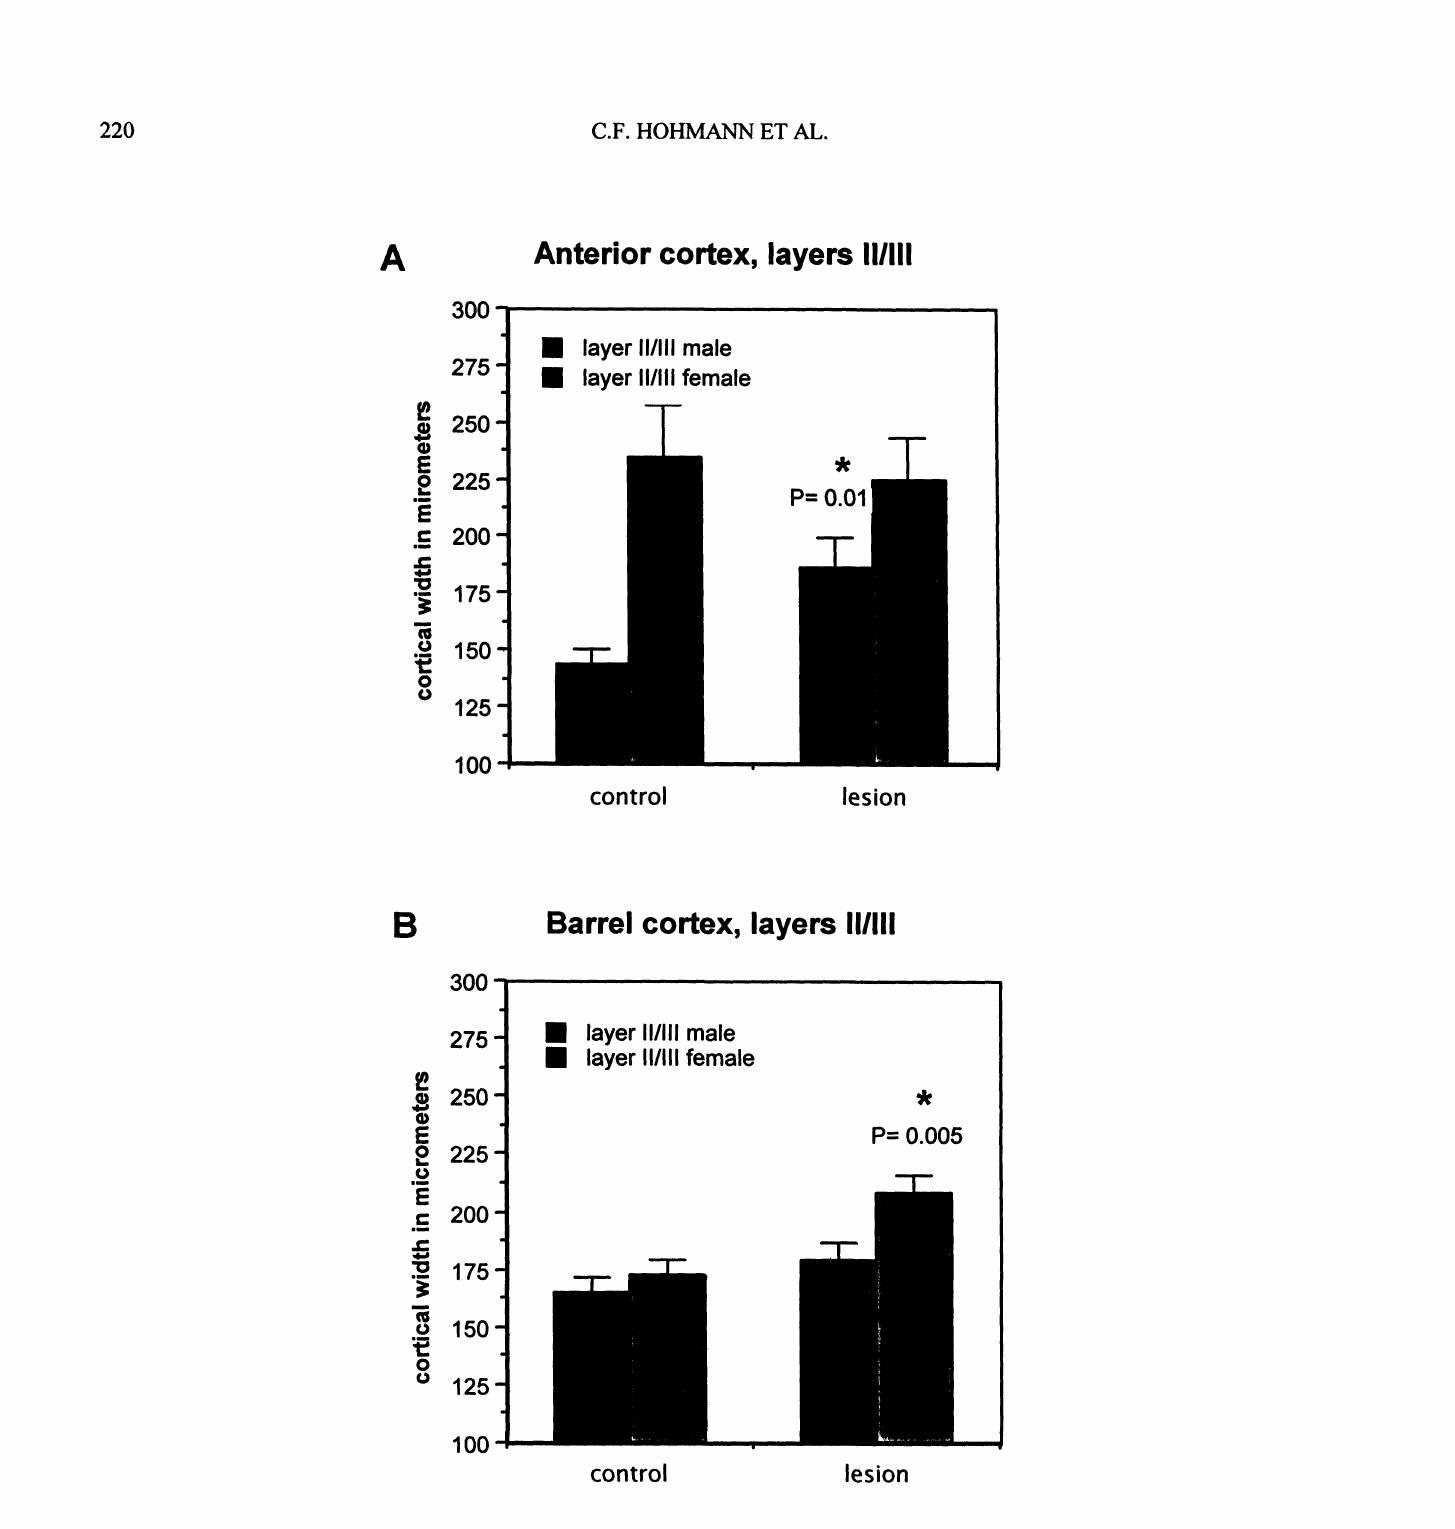
Fig. 3: Comparison of significant changes in layers II/III in anterior (a) and barrel (b) cortex following bilateral neonatal lesions; * denotes significant lesion related differences. Note that males are significantly affected in anterior cortex whereas females are significantly affected in barrel cortex. In total cortical widths in anterior cortex, significant sex differences (see text) in controls are attenuated by the lesion. In contrast, sex differences are exacerbated in barrel